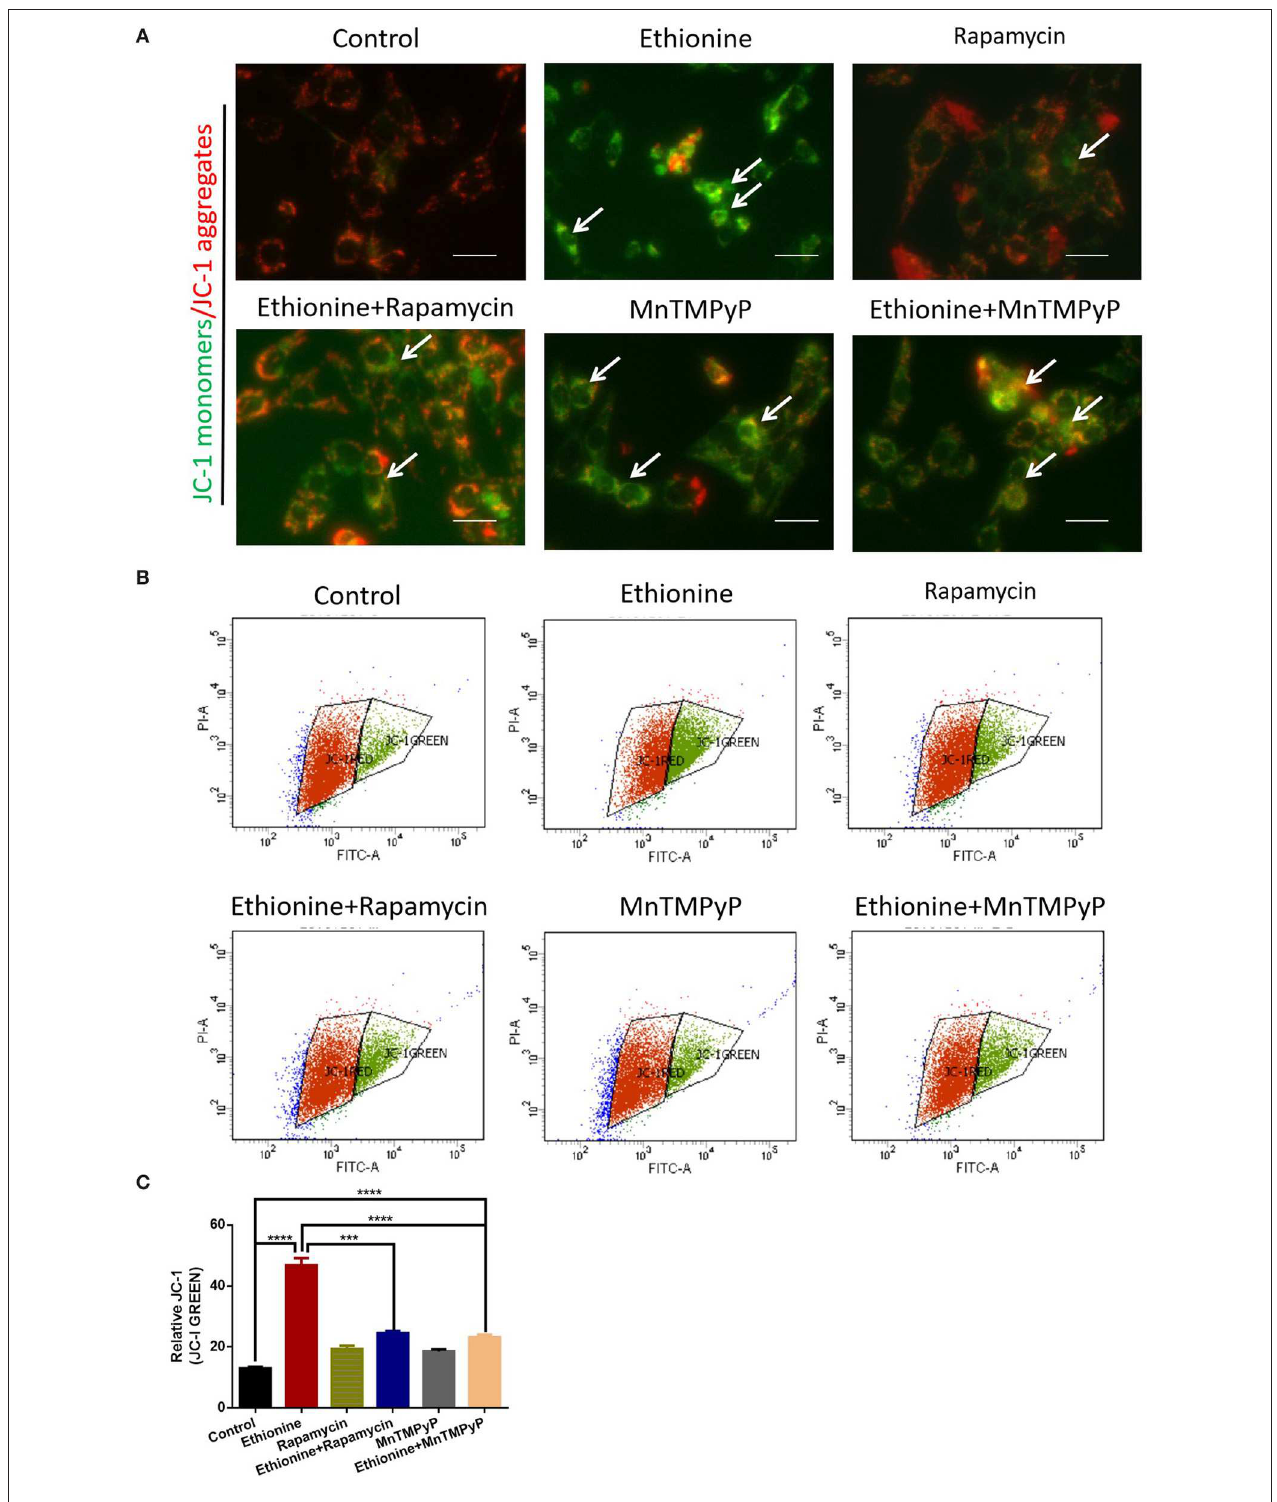
FIGURE 6 | Ethionine suppressed mitochondrial membrane potential. (A) HT-22 cells were treated with ethionine, rapamycin and MnTMPyP, and MMP level was determined using JC-1 dye. Monomers were stained with green and aggregates were stained with red. Representative images are shown. Scale bars: 500 µ m. (B) MMP levels were assessed using JC-1 fluorescence by flow cytometry. (C) Quantification of MMP analysis. Each experiment was carried out in triplicates. *** P < 0.001 and **** P < 0.0001.